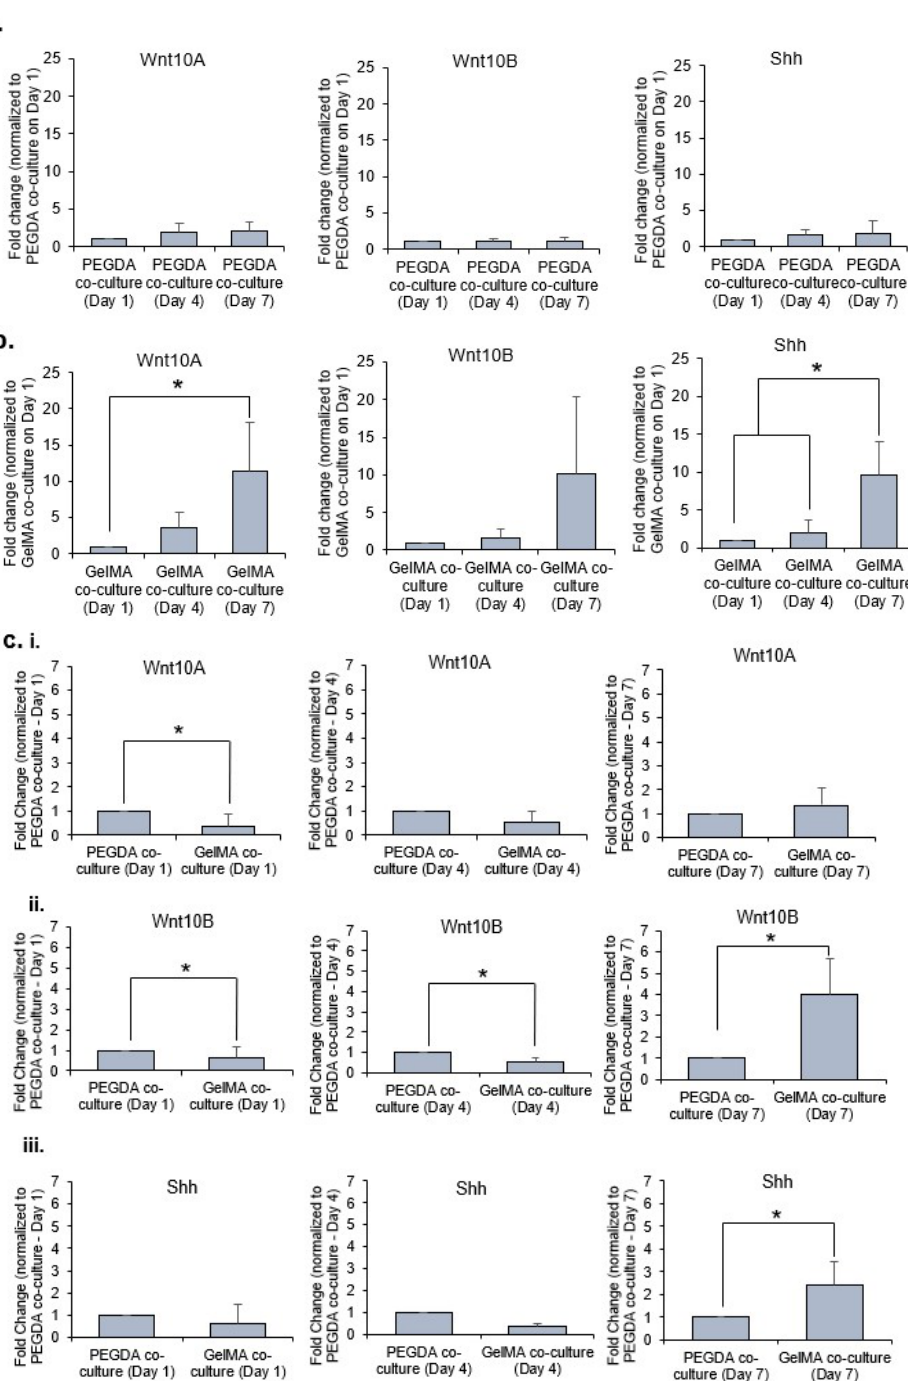
Figure 4. Expression of EMI-related genes (morphogens) of 3D co-cultures within PEGDA and GelMA microwells on day 1, day 4, and day 7 of incubation ( a ). There were no significant changes in the expression of morphogens on day 7 as compared to day 1 for the co-culture within PEGDA microgels ( b ). Expression of morphogens were higher on day 7 as compared to day 1 of co-culture within GelMA microgels (* p < 0.05, as compared to day 1 co-cultures in GelMA microwells) ( c ). Comparing the expression of morphogens between co-cultures in PEGDA and GELMA microwells on day 1, day 4, and day 7 for (i) Wnt10A , (ii) Wnt10B , and (iii) Shh (* p < 0.05 as compared to co-cultures in PEGDA microwells).